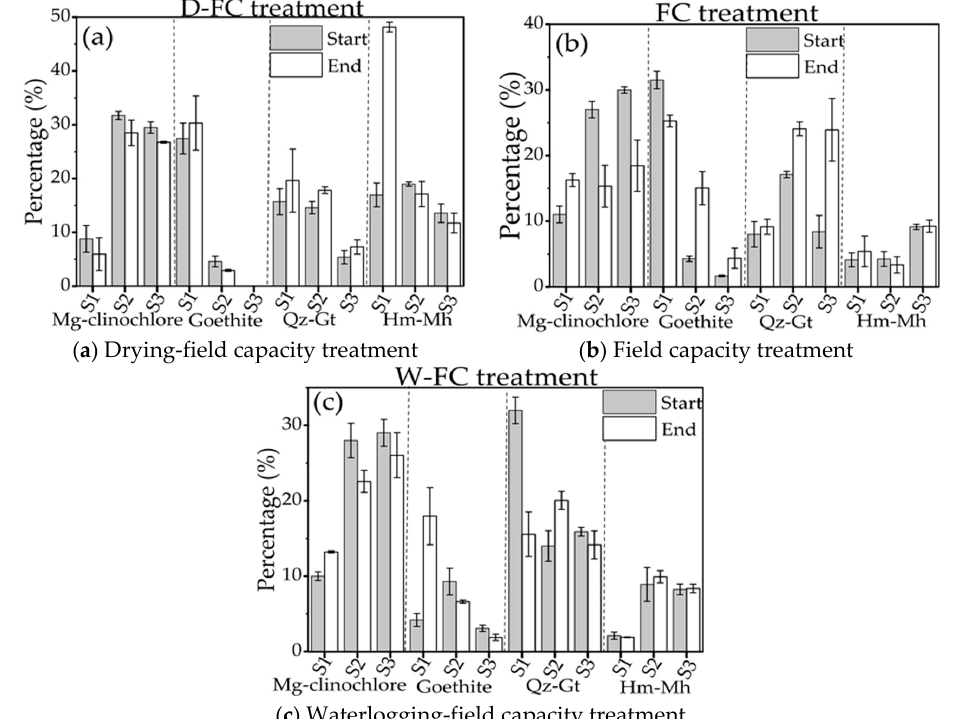
Figure 9 summarized the percentage of the minerals at the start and end of the experiment when the Soil samples were at field capacity. An exception was the Hm-Mh at the D-FC treatment, where the Soil samples were at the dry conditions. Remote Sens. 2019 , 11 , x FOR PEER REVIEW